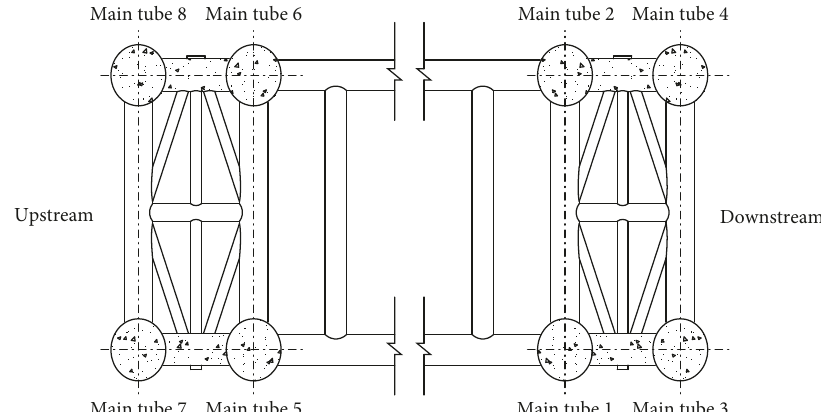
Figure 1: Schematic of the truss section.